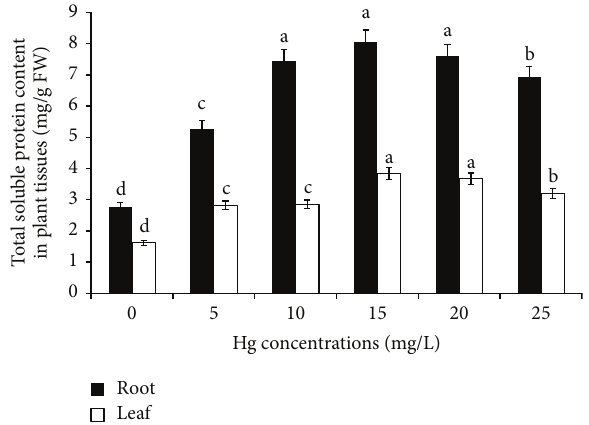
Figure 3: Effect of mercury induced stress on total soluble protein content in M. arvensis seedlings after 12 days of treatment along with untreated control. Values are means ( 𝑛 = 3 ) ± SE; bars followed by the same letters are not significantly different for 𝑃 ≤ 0.05 according to the Duncan’s test.